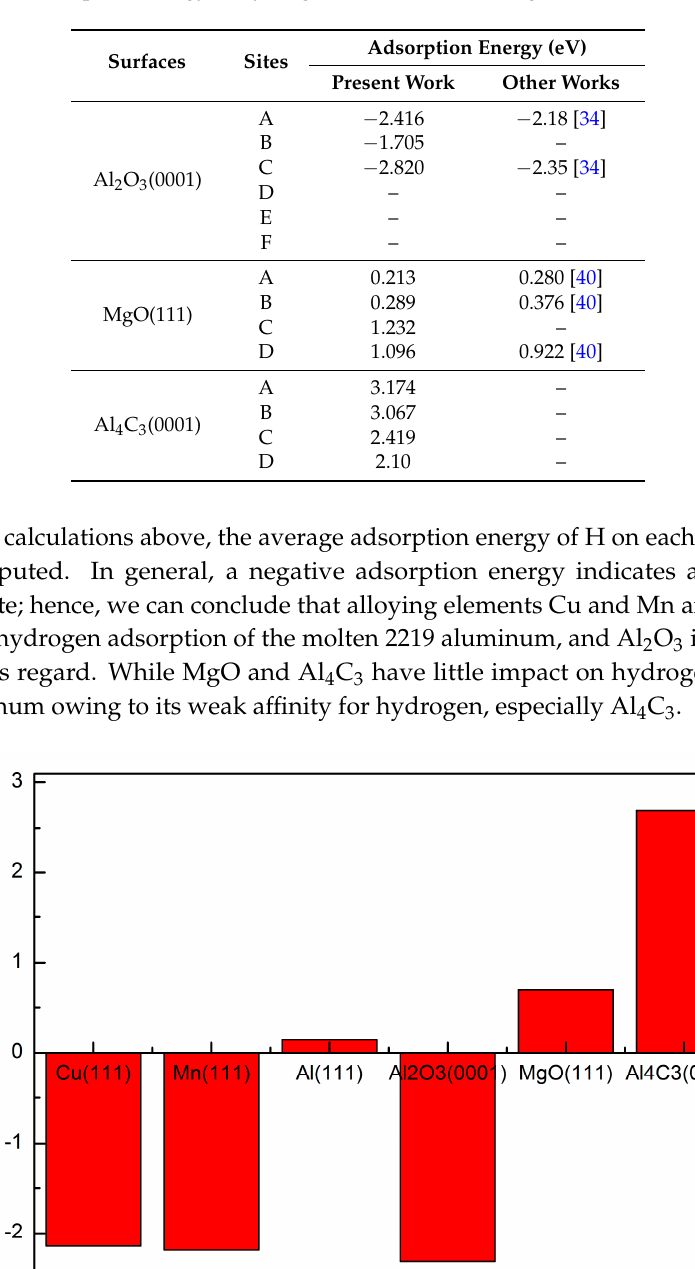
Table 5. Adsorption energy of hydrogen on Al 2 O 3 (0001), MgO(111) and Al 4 C 3 (0001).